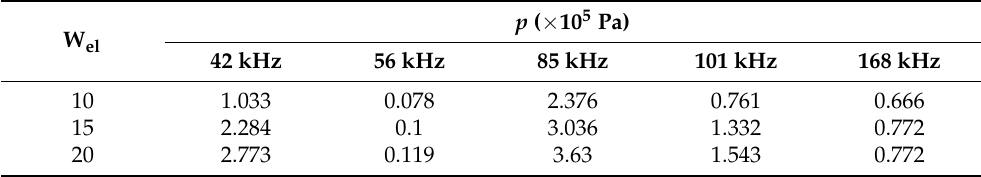
Figure 2. Fixing device for the bottle to the modified transducer ( a ) and amplifier system ( b ). The ultrasonic transducer was a modified 40 kHz Langevin transducer (Hesentec, Rank E), which had a front face adapted to the curvature of the bottle wall (radius r = 44 mm). This modification changed the resonant frequencies of the transducer to 42, 56, 85, 101, and 168 kHz. A arbitrary function generator (TOE7761, Toellner, Herdecke, Ger- many) produced a sinusoidal signal of the corresponding frequency, which was amplified by 51 dBV through a voltage amplifier (1040 L, Electronics and Innovation, LTD, Rochester, NY, USA). A parasitic resistor box was connected between the amplifier and the transducer to protect the amplifier from changing impedances of the transducer (Figure 2b). Power outputs at 10, 15, and 20 W el were investigated. The maximum generated pres- sure amplitudes inside a filled bottle are shown in Table 2 according to hydrophone meas- urements. Table 2. Maximum pressure amplitudes of output frequencies.